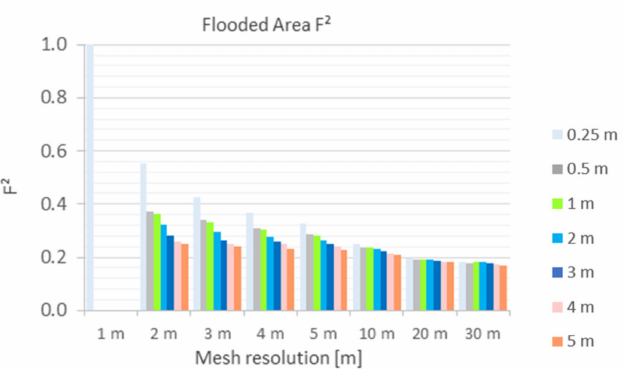
Figure 15. Overview of results of flooded area F 2 for the different mesh and DEM resolutions (DEM: colored legend).